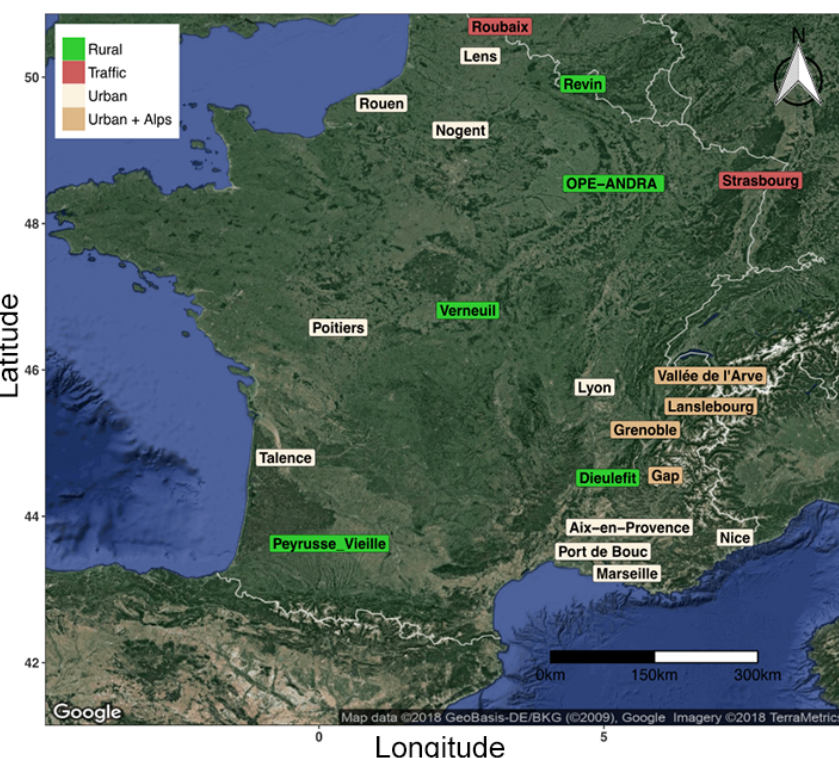
Figure 1. Map of sampling site locations in France. Green: rural background, red: traffic, wheat color: urban background, and dark-wheat color: urban background in Alpine valley sites. The areas of Grenoble (Grenoble_LF, Grenoble_CB, and Grenoble_VIF) and Vallée de l’Arve (Marnaz, Passy, and Chamonix) include three sites each. The area of Marseille includes four sites: Marseille, Mallet, Meyreuil, and